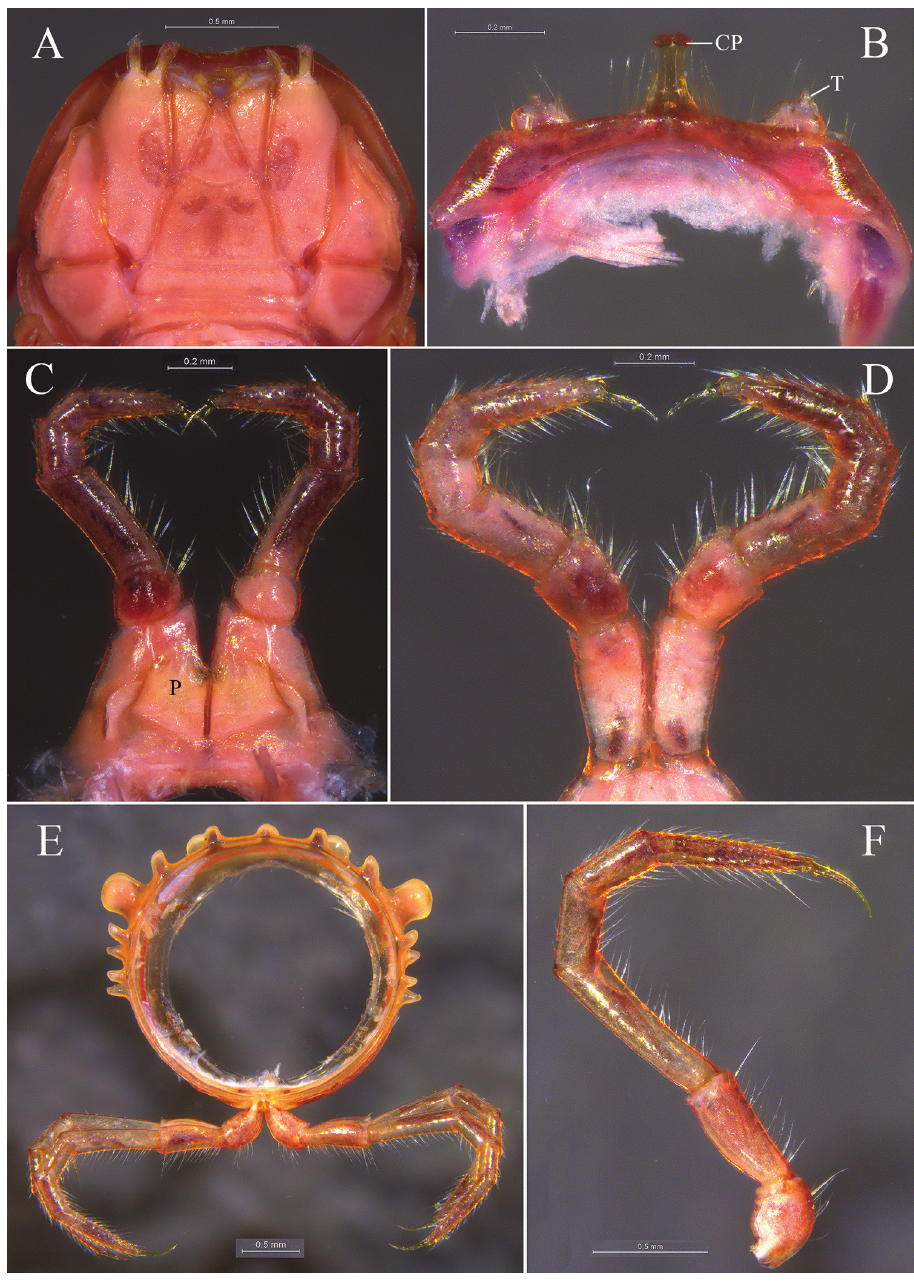
Figure 8. Glyphiulus calceus sp. n., holotype. A gnathochilarium, ventral view B legs I, anterior view C legs II, caudal view D legs III, caudal view E cross-section of a midbody segment, caudal view F midbody leg, anterior view. Abbreviations: CP = coxal process; P = penes; T =